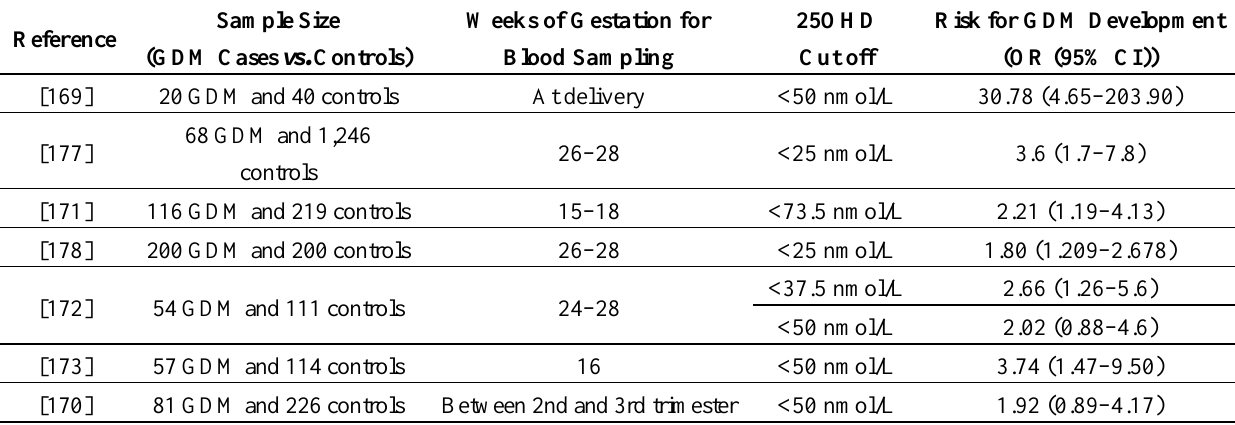
Table 4. Observational studies on 25OHD serum levels and risk for GDM